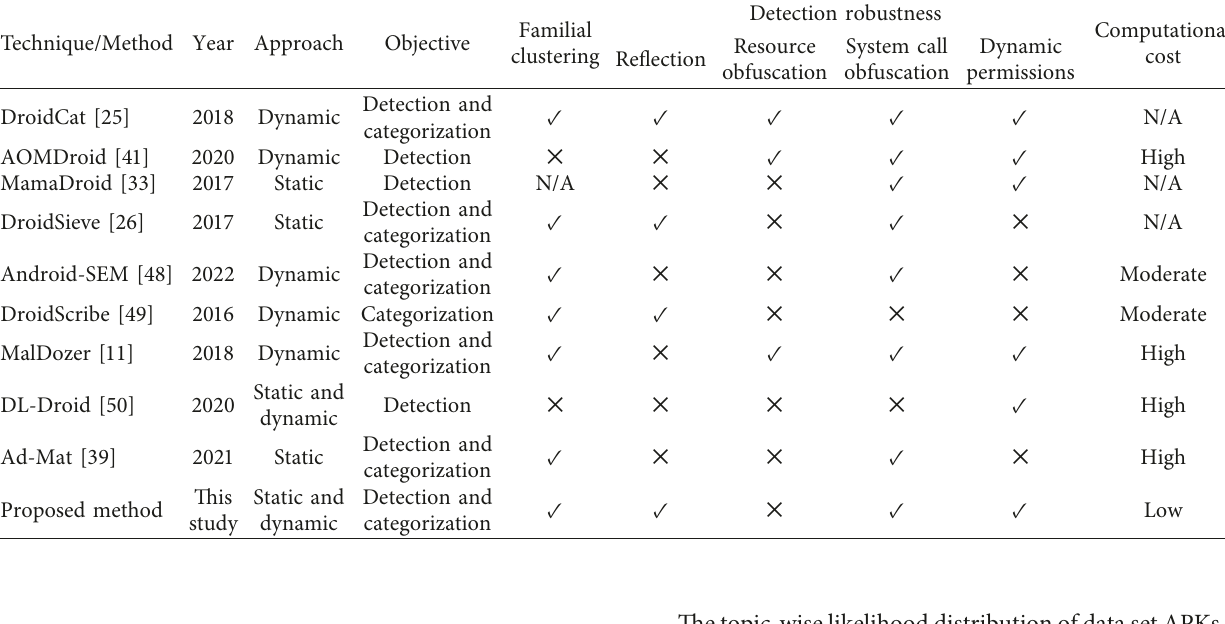
Table 8: Comparative analysis of various Android malware detectors on the basis of objective, clustering, robustness, and computational cost.